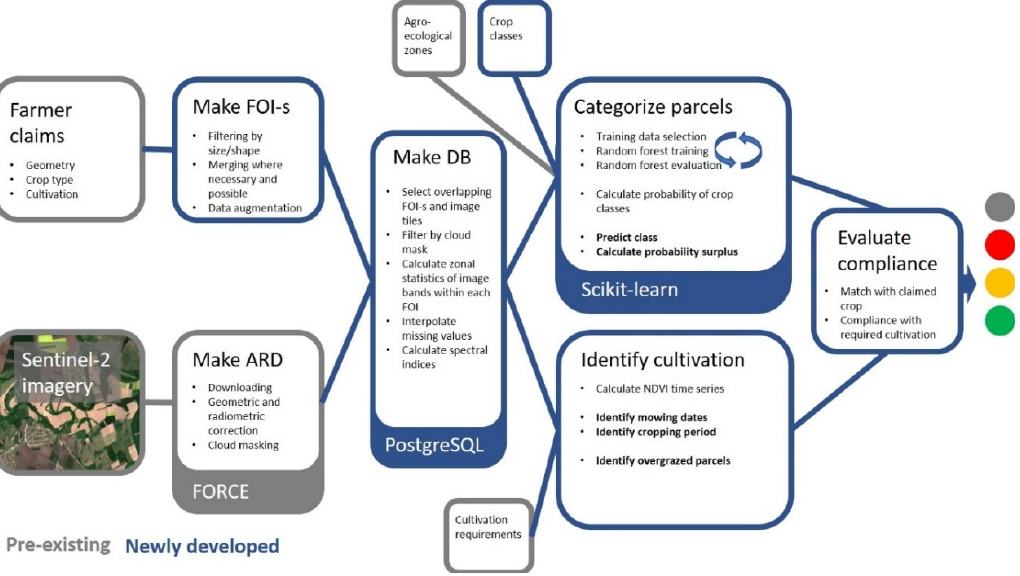
Figure 2. Flowchart of the data analysis workflow for CAP monitoring. Acronyms: FOI—Feature of Interest, individual parcels or merged groups of parcels to be analysed. DB—Database. ARD—Analysis- Ready Data—pre-processed, standardized, consistent